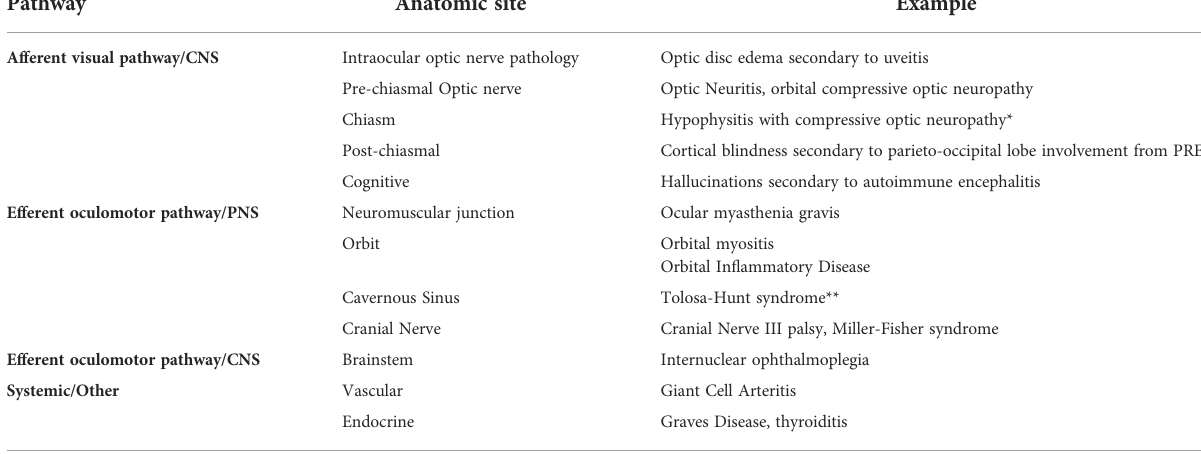
TABLE 2 Proposed anatomical classi fi cation of neuro-ophthalmic immune-related adverse events.